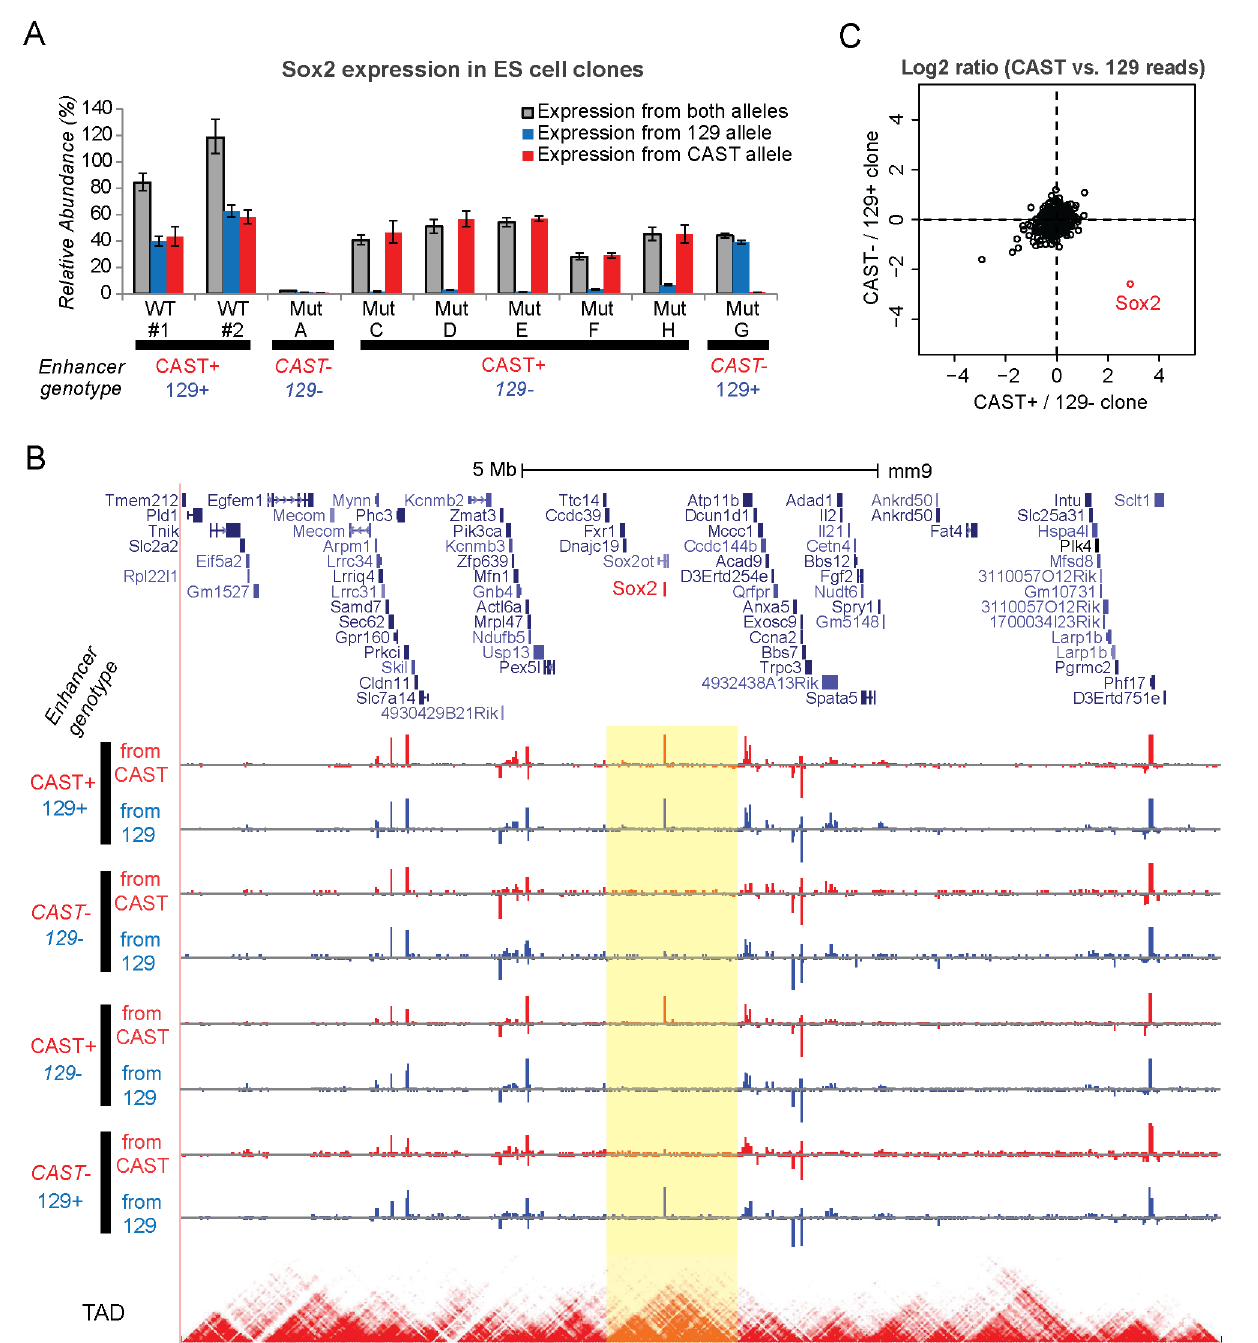
Figure 4. Sox2-SE distal regulates Sox2 expression in cis . ( A ) Allele-specific RT-qPCR analysis of mESC clones with different genotypes. Samples are normalized to the average Sox2 signal between two WT biological replicates. Error bar denotes standard deviation. Note one biallelic Sox2-SE distal deletion clone (Mut B from Fig. 3 ) is missing because we fail to re-expand that clone after freeze and thawing. ( B ) Genome browser tracks showing the RNA-seq signals near the Sox2 locus. Only RNA-seq reads on SNPs between CASTand 129 genomes are plotted. Red tracks: RNA-seq reads on CAST SNPs, the signal above the base line shows transcription from positive strand and the signal below the base line shows transcription from negative strand. Blue tracks: RNA-seq reads on 129 SNPs. The bottom heat map track shows TAD defined by Hi-C. The TAD containing Sox2 gene is highlighted in yellow. ( C ) Comparison of allele-specific expression from RNA-seq in the monoallelic 129 and monoallelic CASTclones. Allele specificity is defined as the log2 ratio of RNA-seq reads from CAST and 129 allele after adding a pseudo count of 10. All genes on chromosome 3 including Sox2 are plotted. Only the Sox2